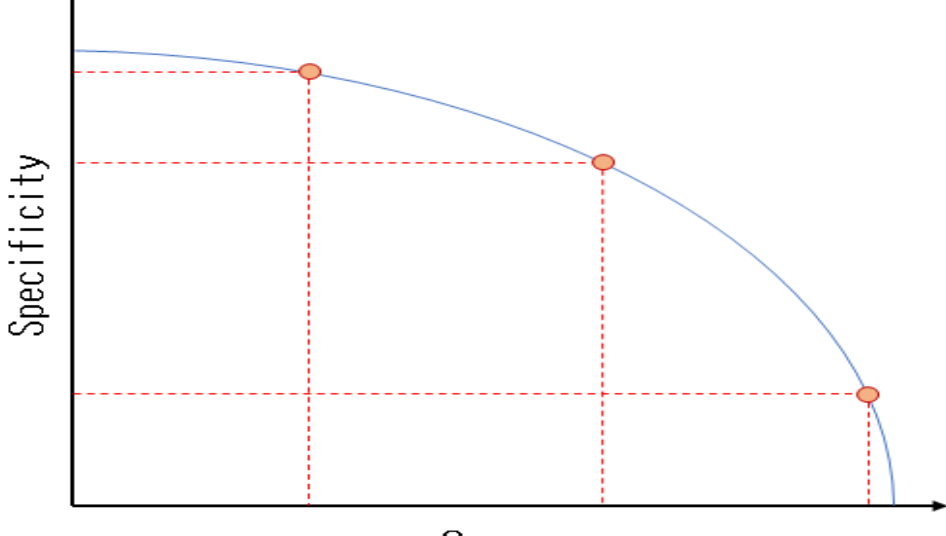
Figure 5. Trade-off relationship between IG coverage and specificity.